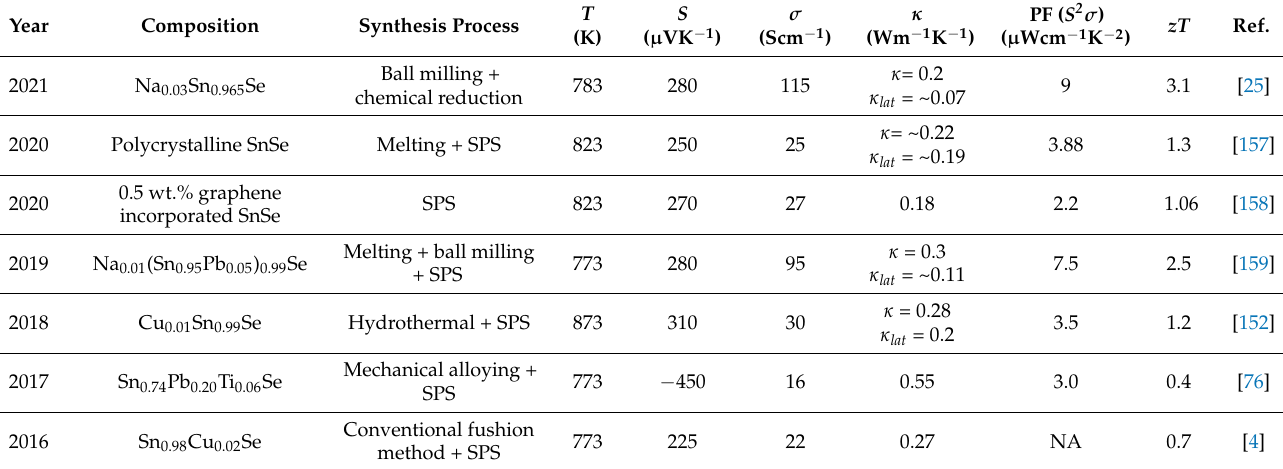
Table 4. TE properties and synthesis of SnSe with reduction of thermal conductivity